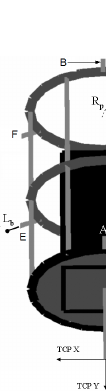
Figure 2: Triangular-link variant of the Gantry-Tau shown in the left-handed configuration for all link clusters.